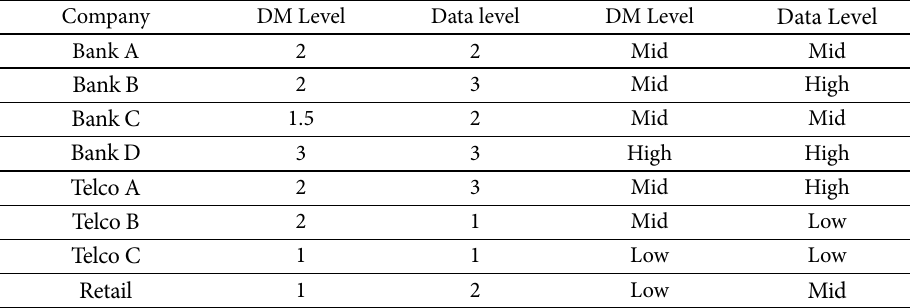
Table 3. The status of data sophistication and data mining sophistication in autumn of